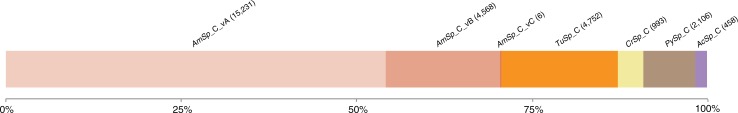
Relative silk gene expression in female Tengella perfuga silk glands.Silk transcripts containing the C-terminal domain are shown. Average expression from two biological replicates of T. perfuga total silk gland library reads mapped to our de novo T. perfuga transcriptome. Expression is shown as reads per kilobase of transcript per million mapped reads (RPKM, average total for each transcript shown in parentheses). Colors indicate spidroin types as in Fig 1. Names abbreviated as in S2 Table. Total RPKM of silk genes 28,114.